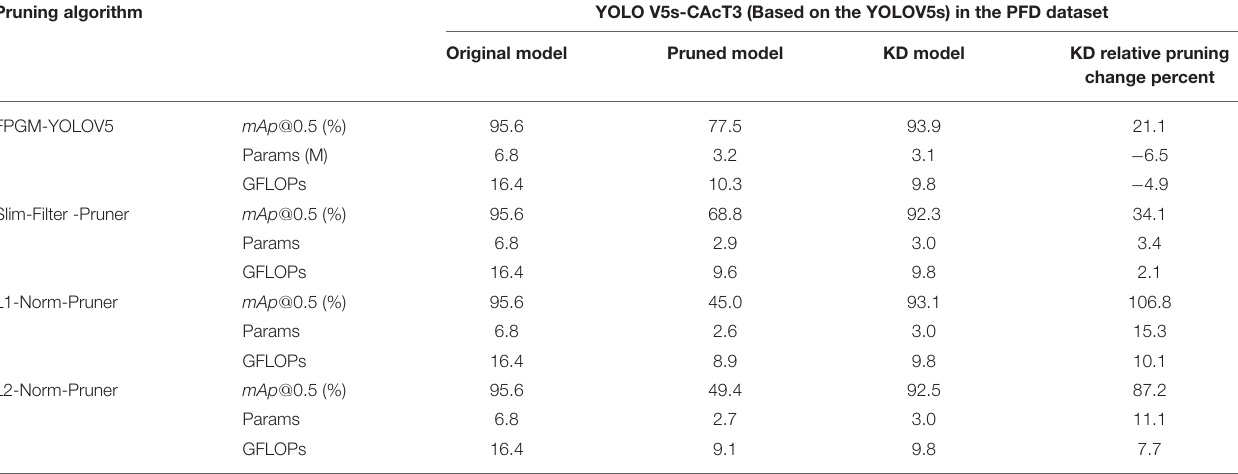
TABLE 9 | Performance comparison of the original model, the trim rate 0.4 model, and the distillation temperature T of 15 models. Pruning